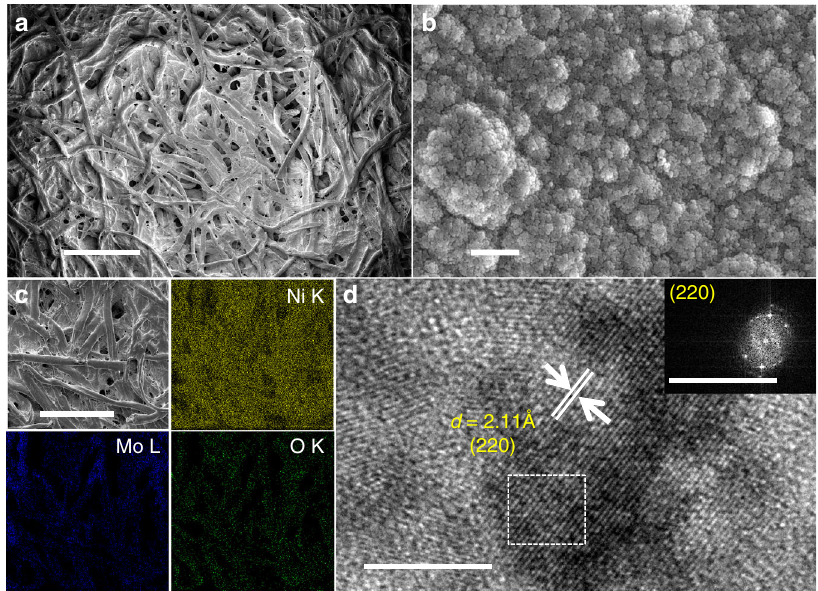
Fig. 4 High resolution FE-SEM and HR-TEM micrographs of NiMo/Ni-P electrode. a Low (scale bar 100 μ m) and b high resolution FE-SEM images of Ni 4 Mo nanoparticulates on Ni-P (NiMo/Ni-P) (scale bar 200 nm). c EDX elemental mapping of the NiMo/Ni-P electrode surface (scale bar 200 μ m). d TEM image showing the lattice fringes of Ni 4 Mo phase (scale bar 5 nm) and inset shows the SAED pattern obtained from the area marked in white (scale bar 20 nm − 1